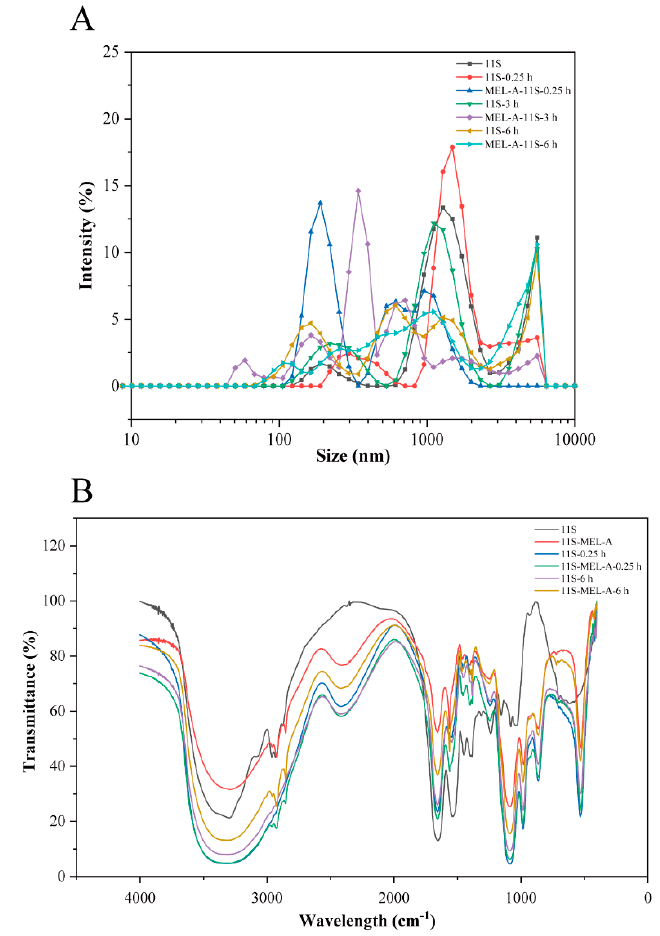
Figure 3. Effect of MEL-A on molecular size and chemical structure of 11S upon heating treatment. ( A ) Size volume distributions of 11S and 11S-MEL-A. ( B ) FTIR spectrogram of 11S and 11S-MEL-A with heat treatment (0.25 h and 6.0 h). The native protein served as a control.